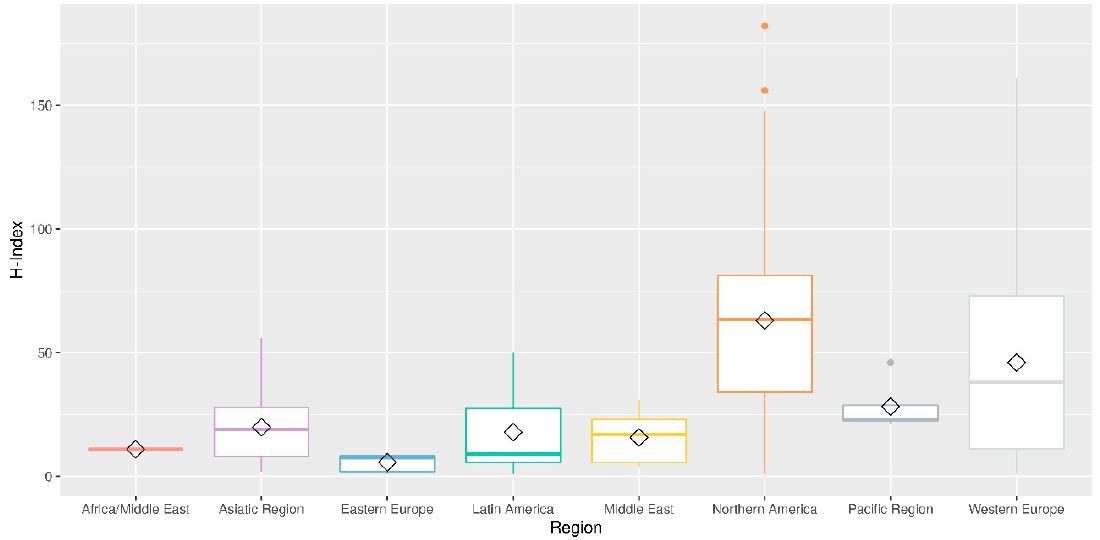
Figure 3. Global comparison of H-Index between all regions.